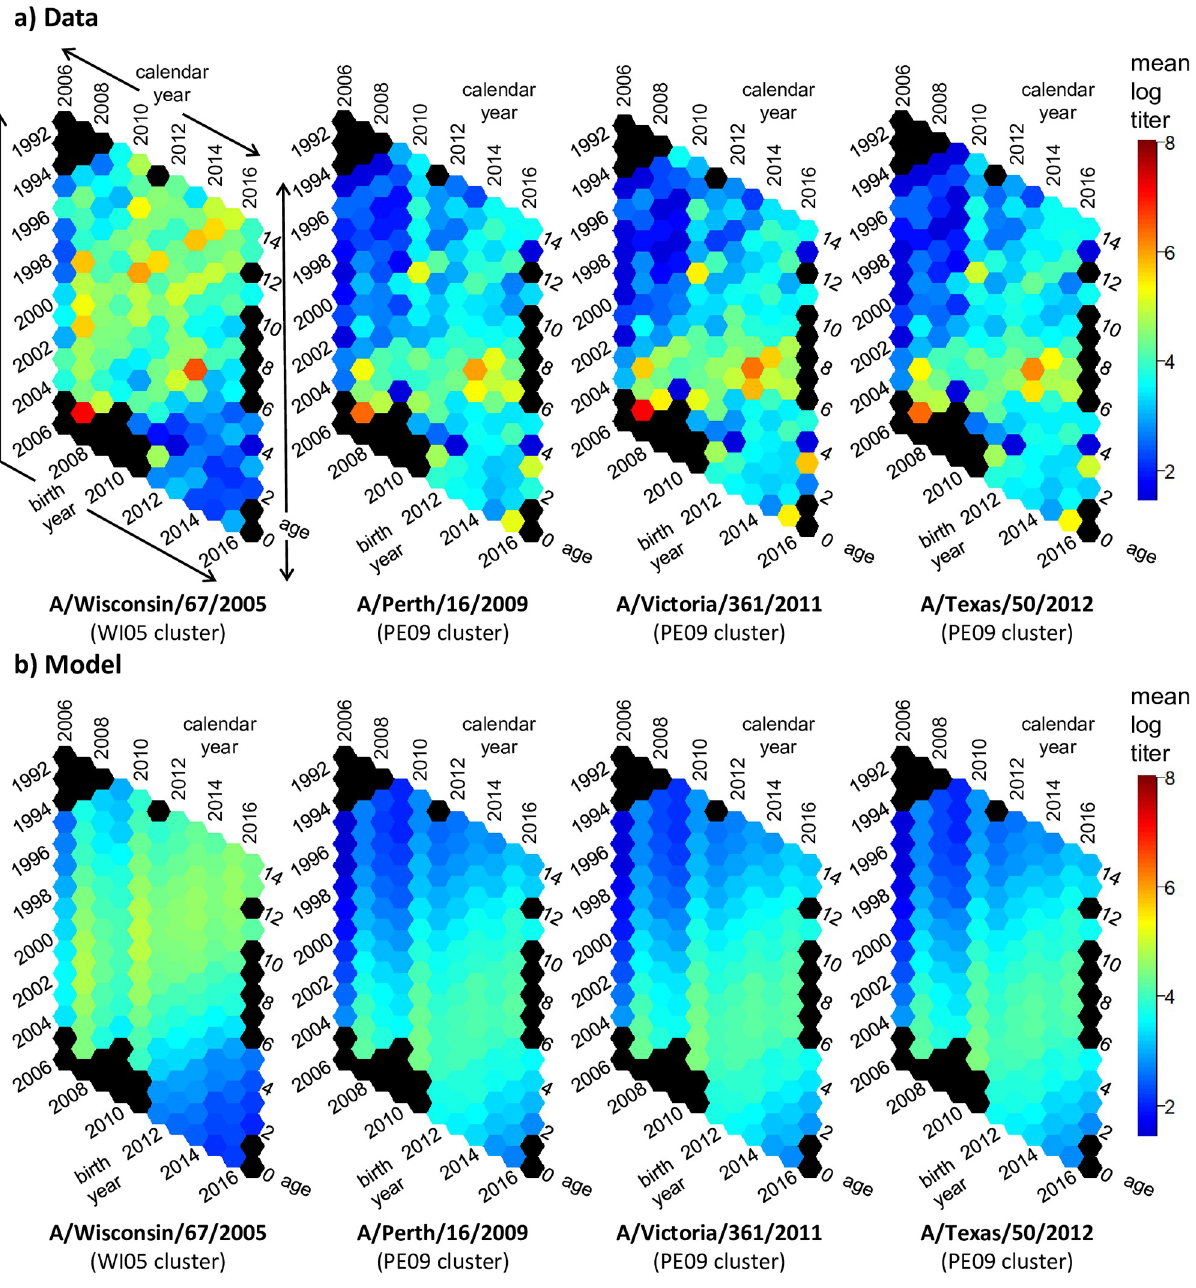
Fig 3. H3N2 hexamaps for HAI titers. a) Hexamaps visualizing H3N2 HAI mean log titers as a function of age, calendar year, and birth year in the data. b) Corresponding hexamaps for the mean log titers predicted by the H3N2 subtype-specific model. Black hexagons represent points with no